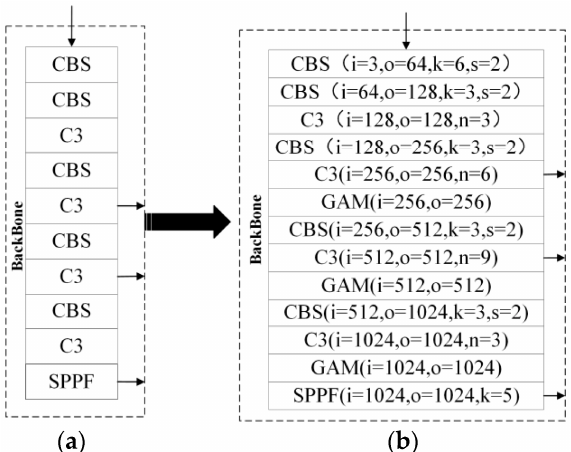
Figure 4. Comparison of backbone network improvements. ( a ) YOLOv5 backbone network structure. ( b ) YOLO-GBC backbone network